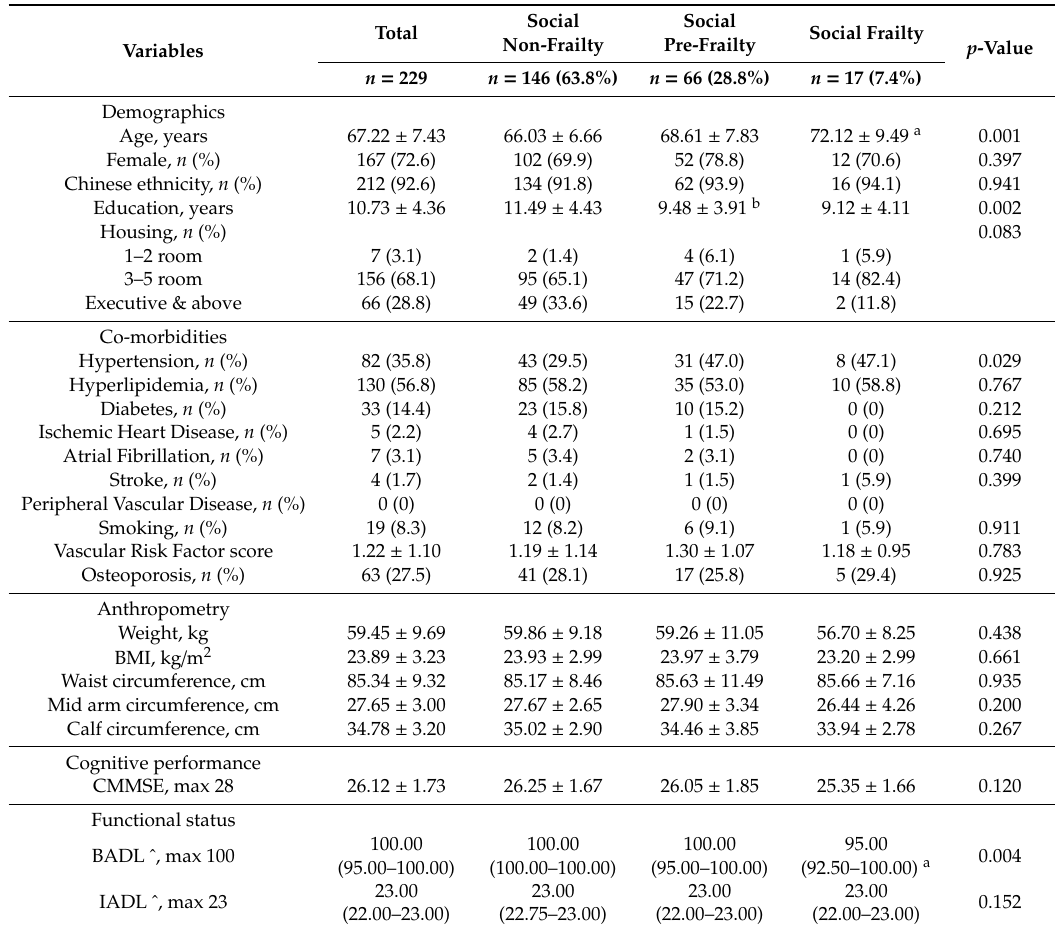
Table 1. Baseline characteristics of study cohort ( n =